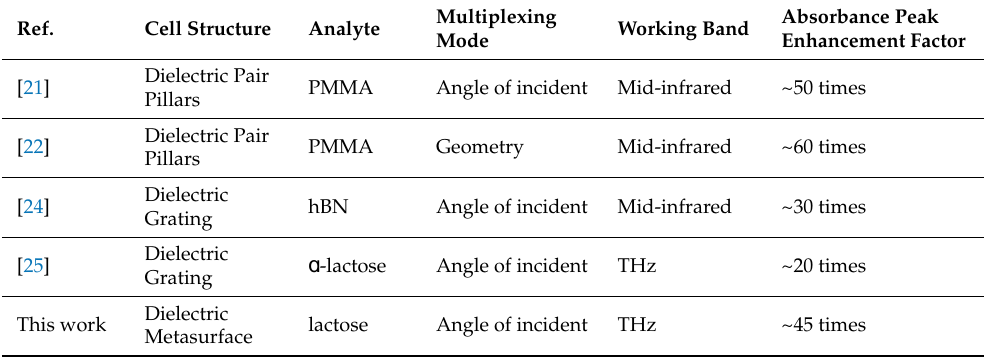
Table 1. Comparison of absorption spectra enhancement performances of present metasurfaces or gratings based on multiplexing technology and our designed structure. Ref.